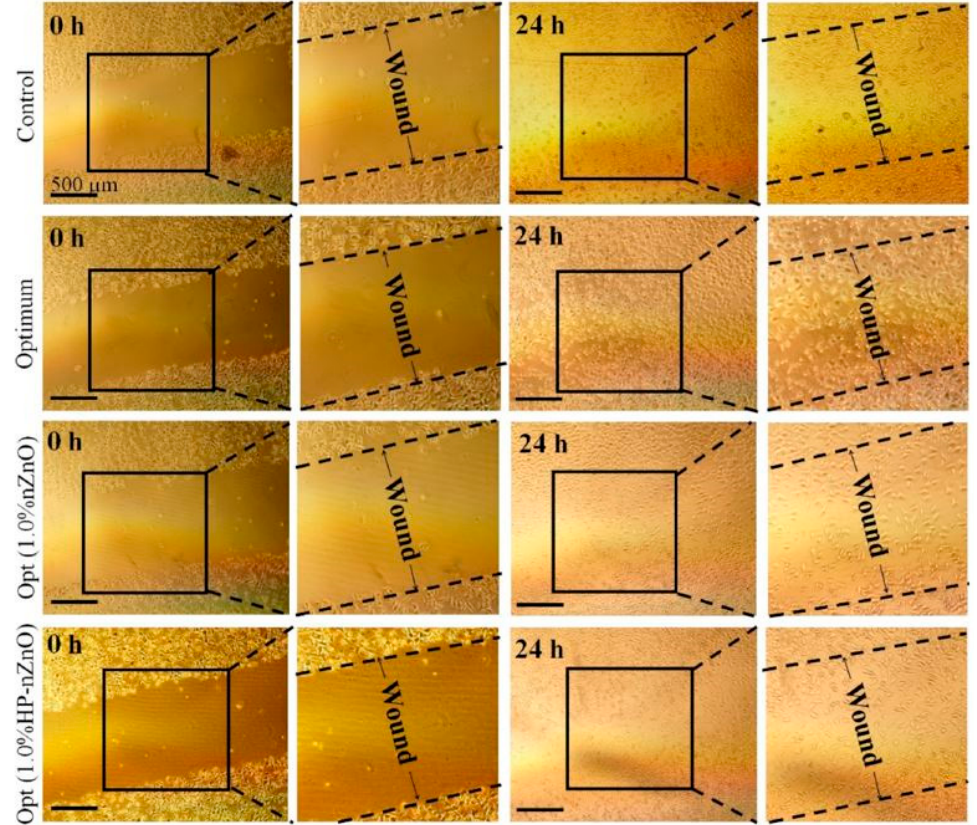
Figure 3. The scratch assay was conducted on prepared wound dressings materials (1% nZnO and 1% HP-nZnO). Reprinted with permission from [83], copyright 2019 Elsevier.